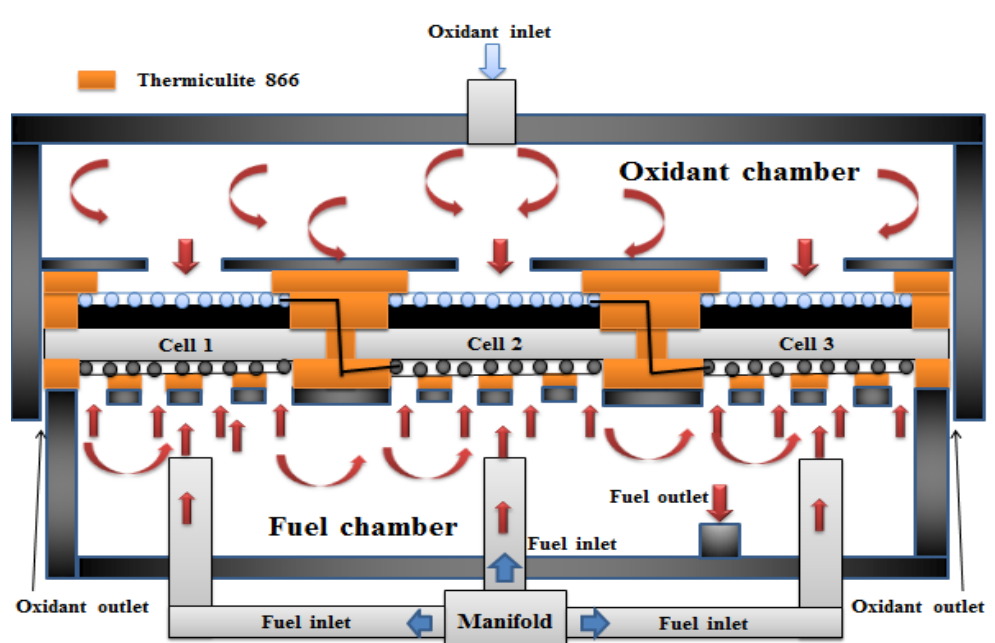
Figure 3. Schematic of the working principles of a 2D configuration SOFC stack.